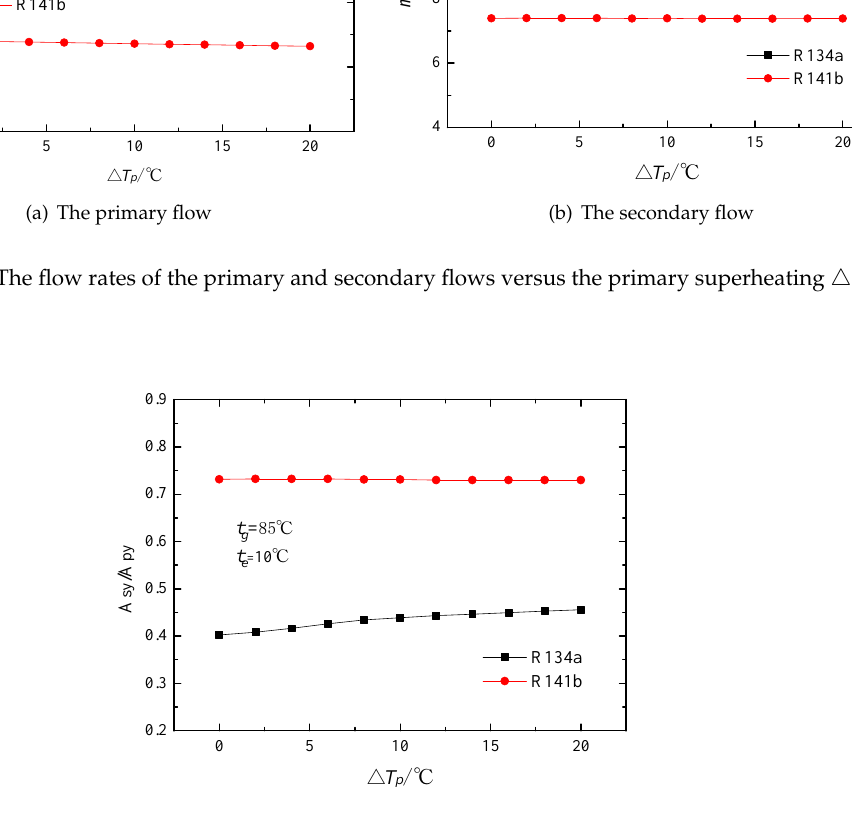
Figure 13. Area ratio A sy / A py versus the primary superheating (cid:52) T p